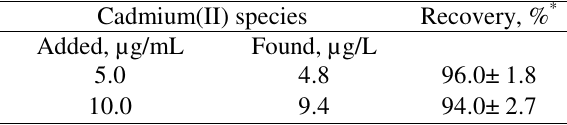
Table 1. Analytical results for the preconcentration and recovery of cadmium(II) in wastewater samples by the compound II immobilized PUFs packed